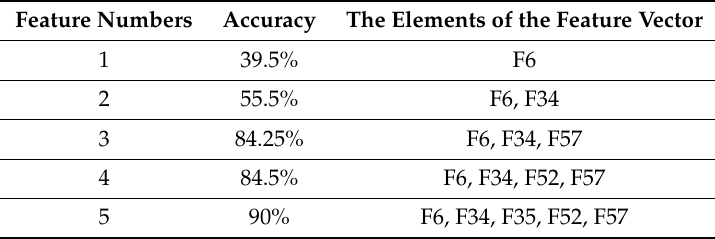
Table 5. Result of CFFS.